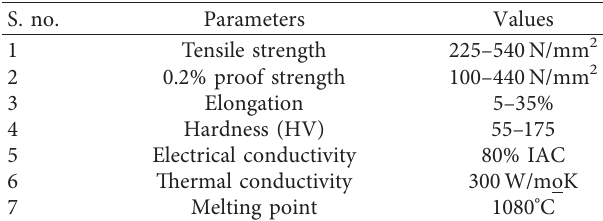
Figure 2: Schematic plasma reactor. Table 2: Properties of polymer zirconium